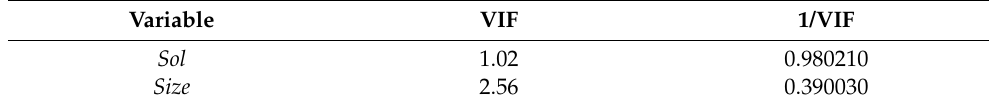
Table 2. Variance inflation factors of main